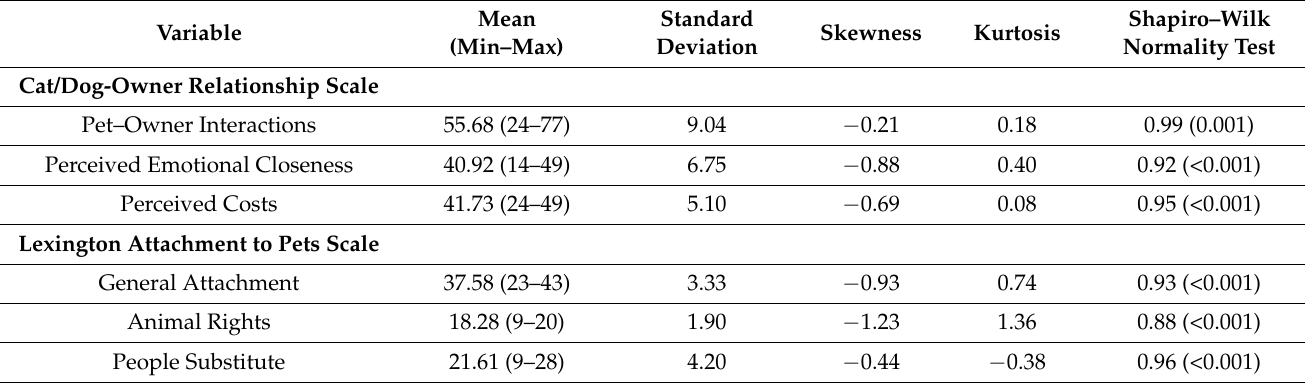
Table 1. Descriptive statistics of the scales used in the